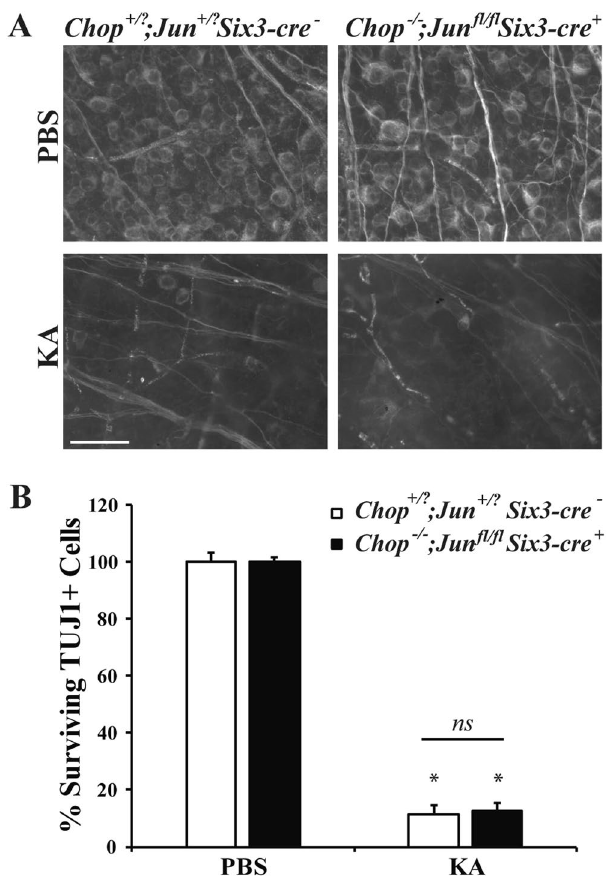
Figure 11. Combined Jun and Ddit3 deficiency does not attenuate loss of RGCs after KA insult. (A) Representative images showing TUJ1 immunolabeled cells in the GCL of Jun and Ddit3 deficient ( Jun fl/fl Ddit3 − / − ; Six3-cre + ) mice 7 days after intravitreal KA or PBS injection. Significant RGC loss occurred in wildtype ( Jun + /? Ddit3 + /? ; Six3-cre − ) as well as Jun and Ddit3 deficient mice after KA insult (n = 5 for PBS WT, n = 3 for NMDA WT, n = 4 for PBS Jun + /? Ddit3 + /? ; Six3-cre − , n = 3 for NMDA Jun + /? Ddit3 + /? ; Six3-cre − ). (B) Quantification of TUJ1 + RGCs confirmed that Jun and Ddit3 deficient mice had a similar loss of RGCs compared to wildtype mice 7d after NMDA injection ( * p < 0.001 comparing PBS to KA; p = 0.9962 between WT and Jun fl/fl Ddit3 − / − ; Six3-cre + KA, ns between genotypes). Scale bar: 50 μ